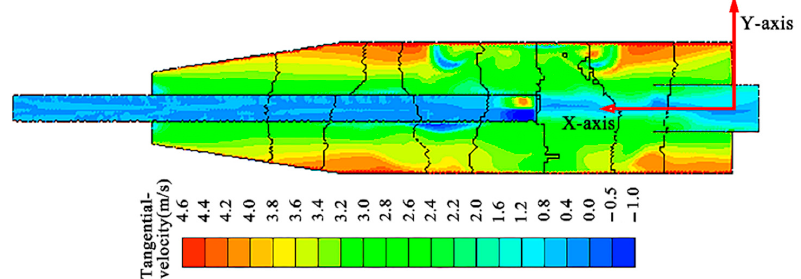
Figure 9. Tangential velocity distribution at central section (rotational speed is 900 r/min).